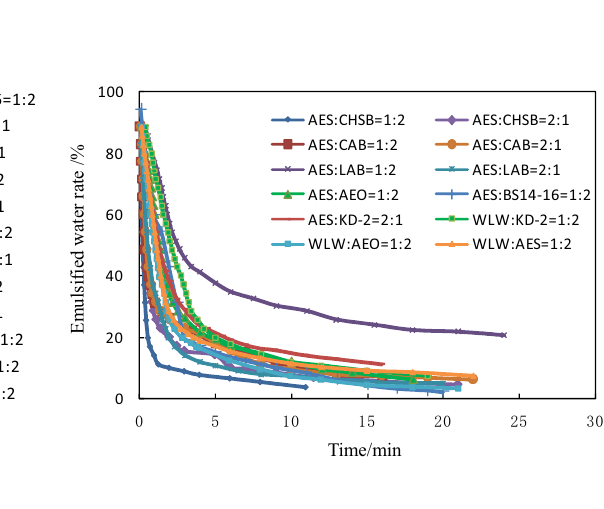
Fig. 4 (left) IFT and (right) emulsification test results of surfactant mixture